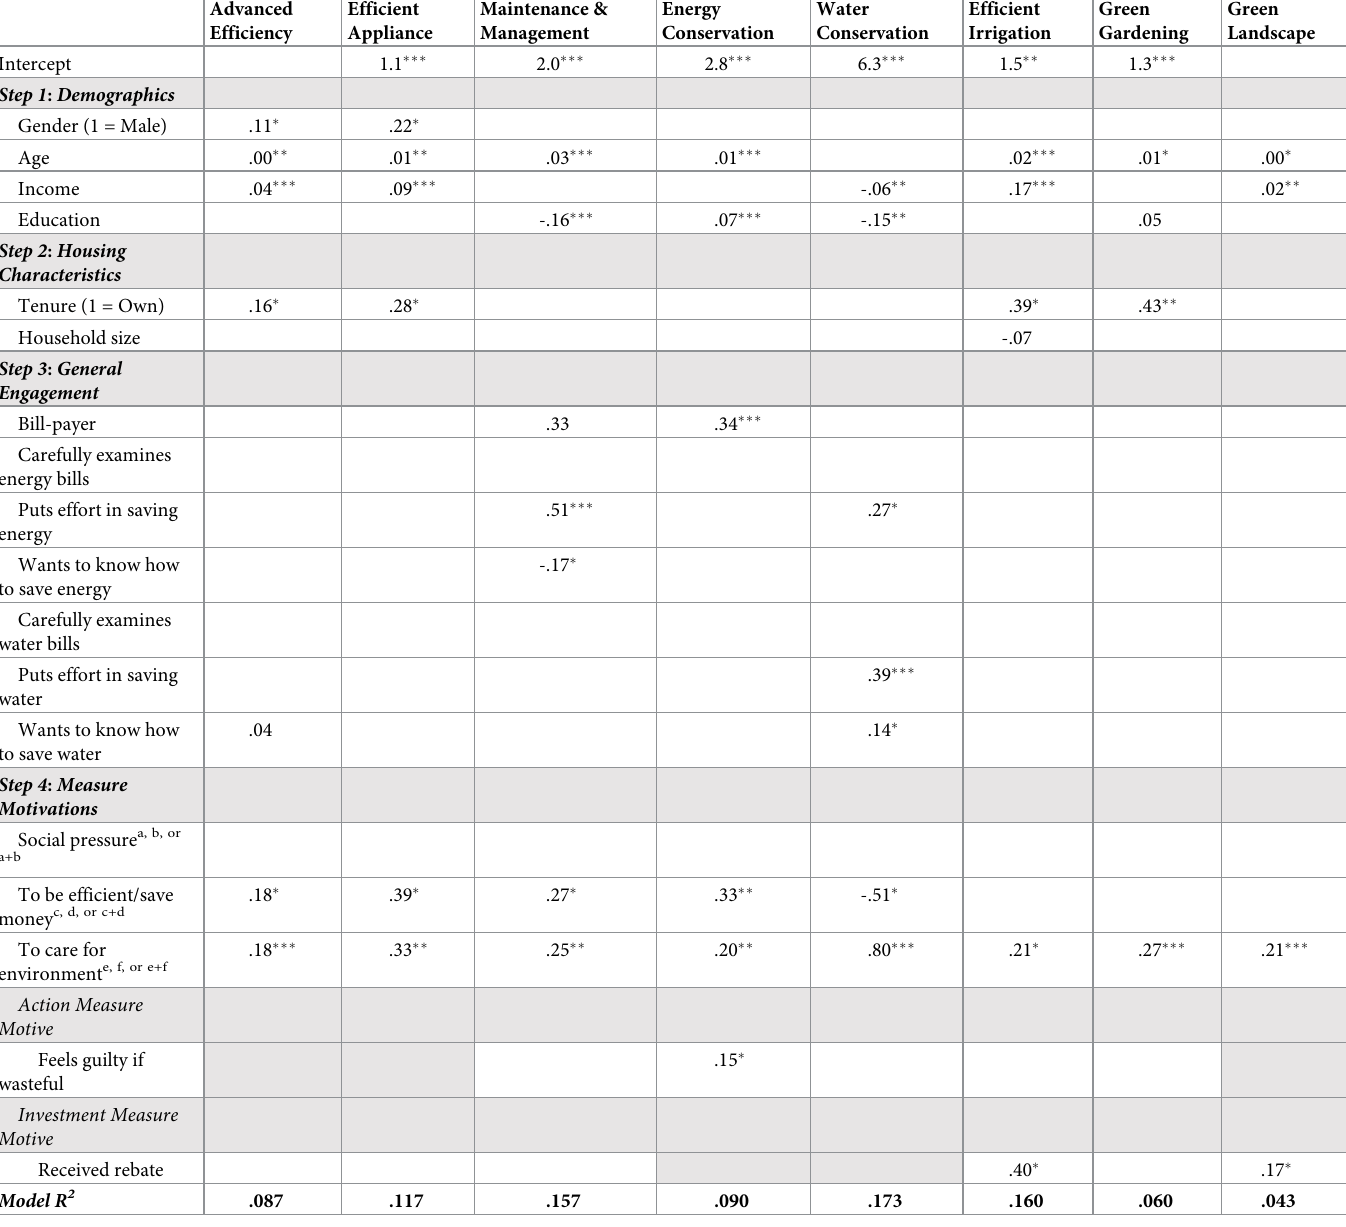
Table 7. Regression models exploring predictors of measure class